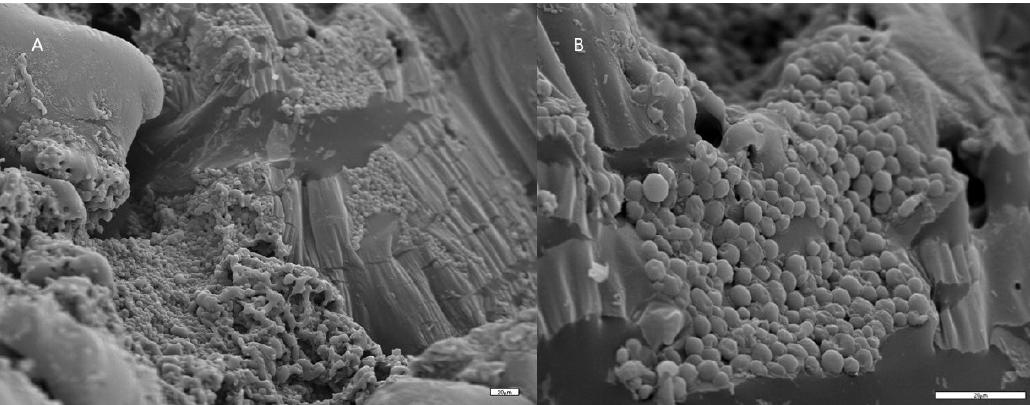
Figure 1. Electron micrographs of Saccharomyces cerevisiae AXAZ-1 immobilized on Pistacia terebinthus resin. A. magnification ×300, B: magnification ×1000.